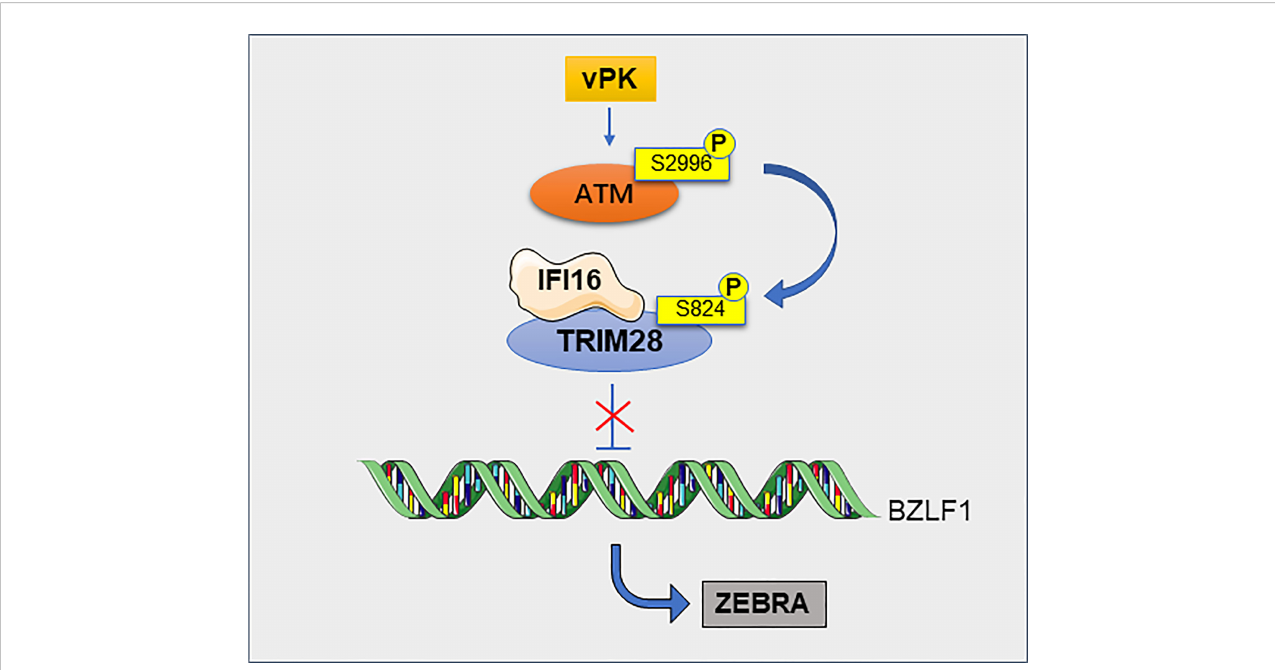
FIGURE 7 TRIM28 contributes to the maintenance of EBV latency. TRIM28 interacts with IFI16 and this cooperation silences the EBV cleavage switch protein ZEBRA encoded by the BZLF1 gene, thereby maintaining viral latency. Viral protein kinase (vPK) activates cellular phosphatidylinositol 3 kinase-associated kinase ATM via atypical site phosphorylation, leading to the phosphorylation of TRIM28, this phosphorylation making it impossible to inhibit ZEBRA and ultimately to viral